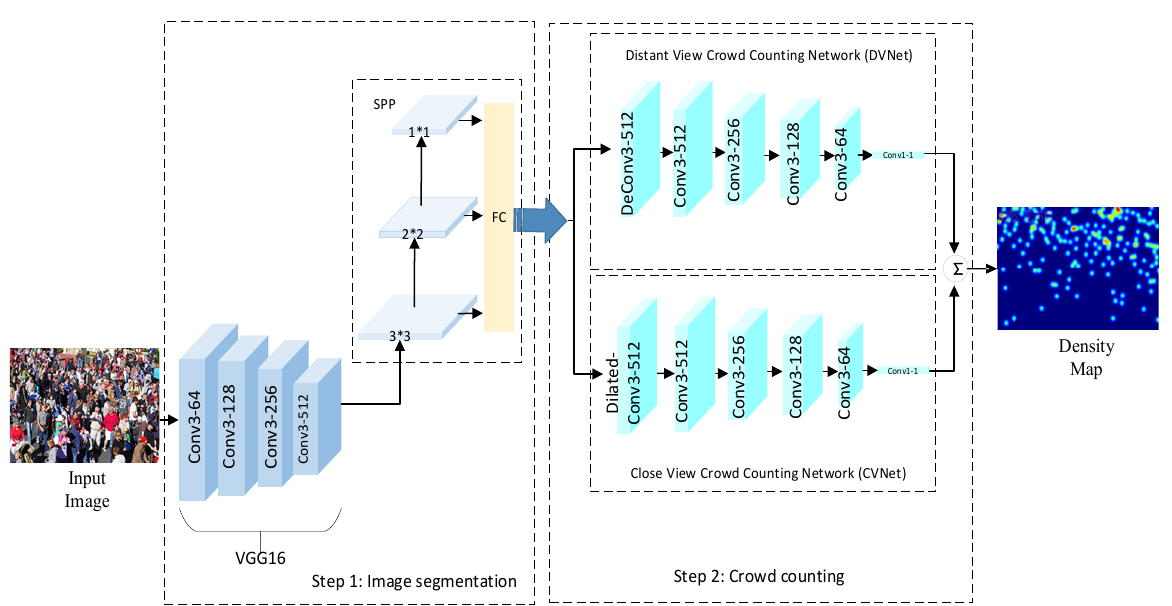
Figure 1. The Architecture of SASNet. The SASNet mainly covers two stages. The first stage is the image segmentation, and the second stage is the crowd counting.